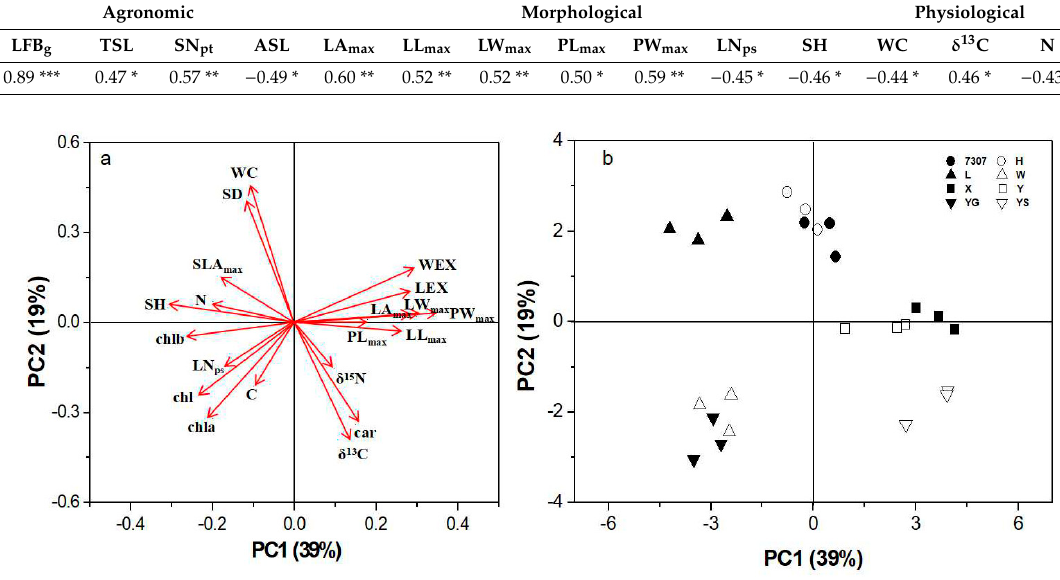
Figure 5. Principal component analysis (PCA) plots of morphological and physiological traits in the orthogonal plane (PC1 × PC2) for the eight studied mulberry